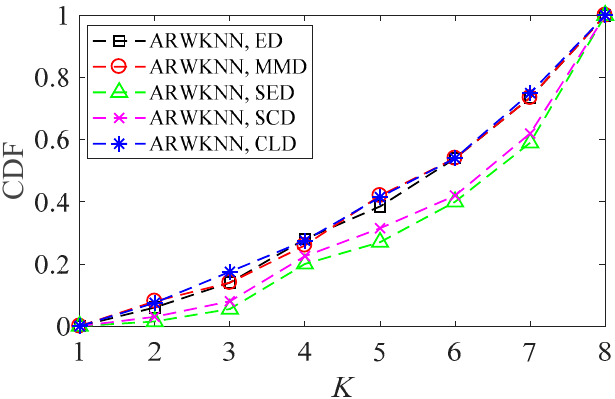
Figure 23. In 3-D, the cumulative distributions of the optimal K with K max = 8.